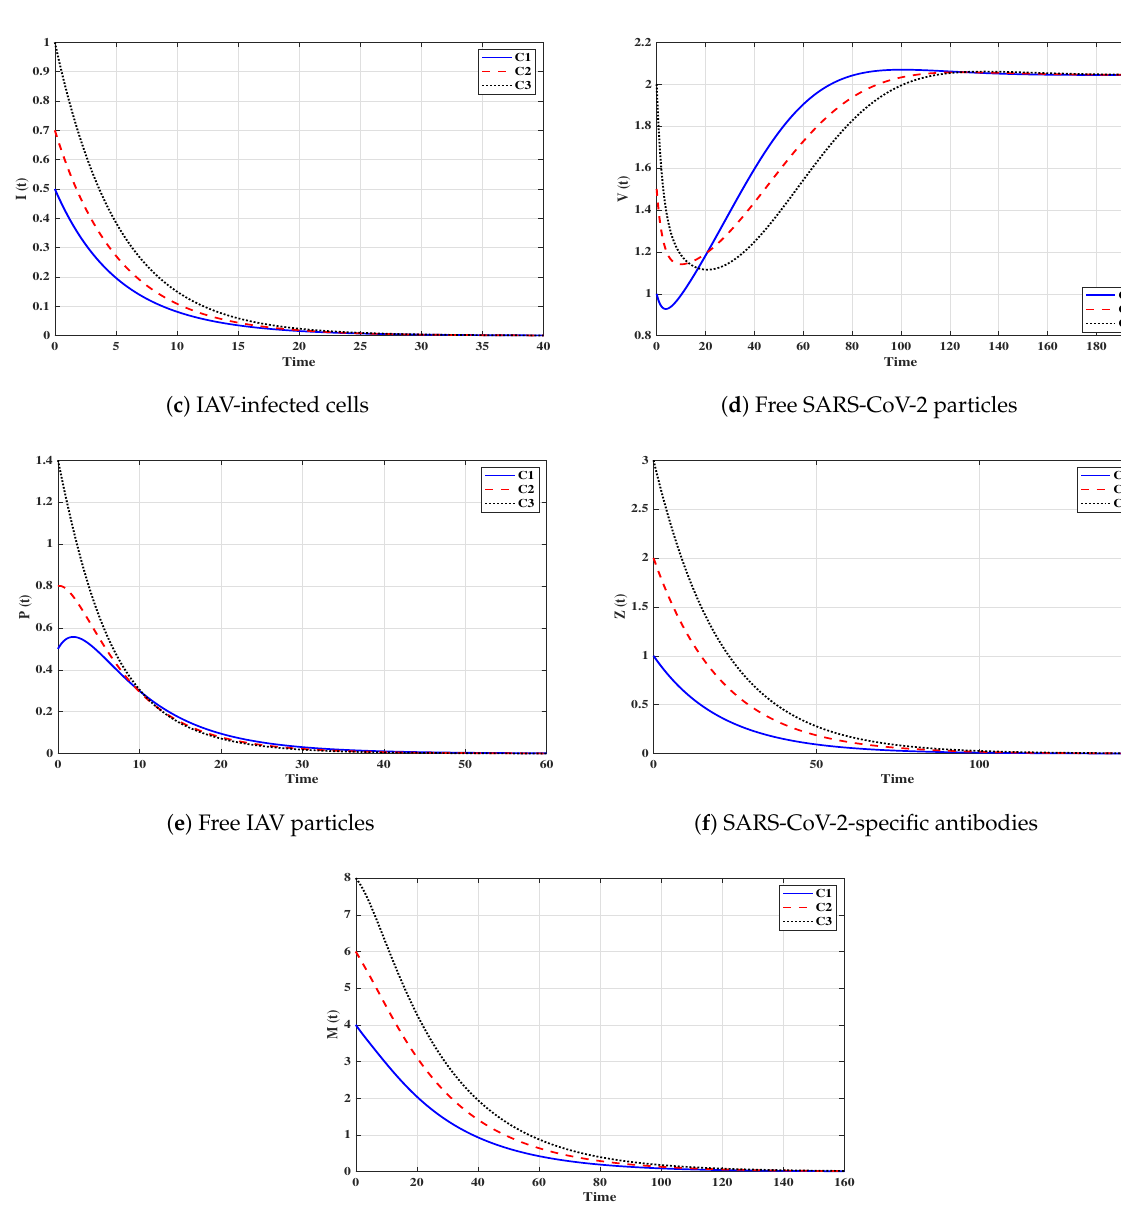
Figure 3. Solutions of system (3) with initials C1–C3 tend to Ξ 1 = ( 5.5,2.05,0,2.05,0,0,0 )